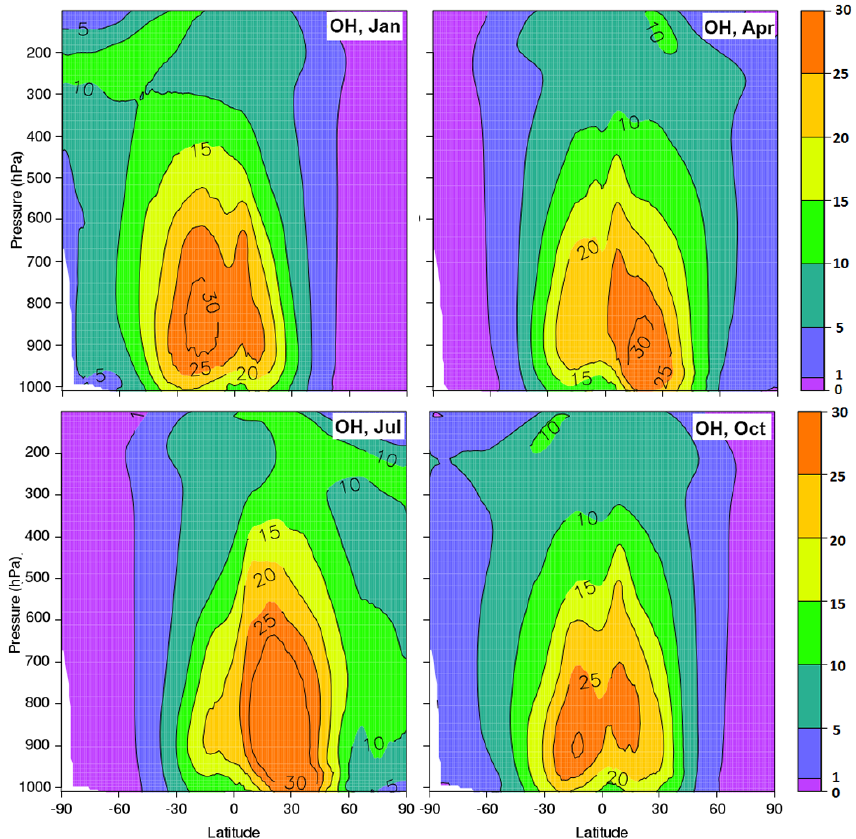
Figure 2. Zonal monthly mean OH concentrations (10 5 moleccm − 3 ) for January, April, July and October by the NMMB-MONARCH